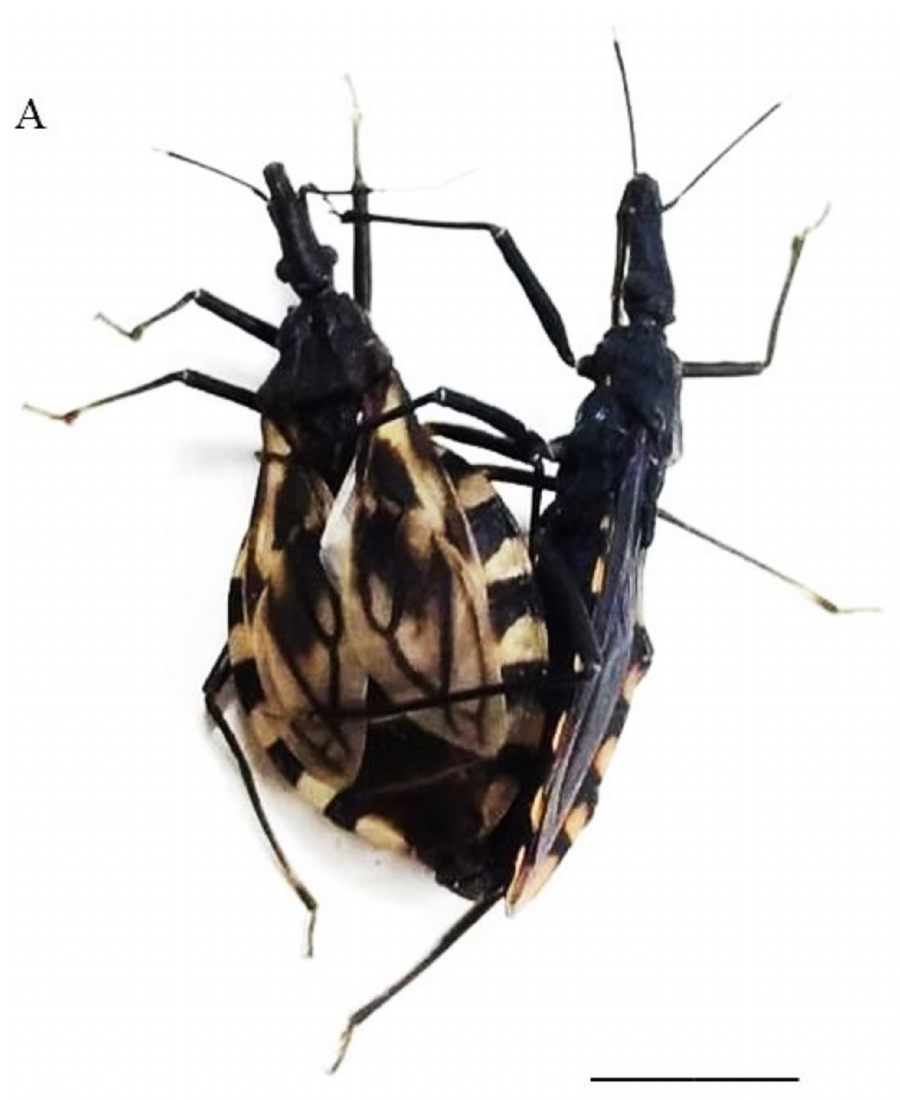
Fig 1. Example of interspecific copulation observed among species of the T . brasiliensis complex: T . juazeirensis female x T . lenti male. Bar: 5 cm.